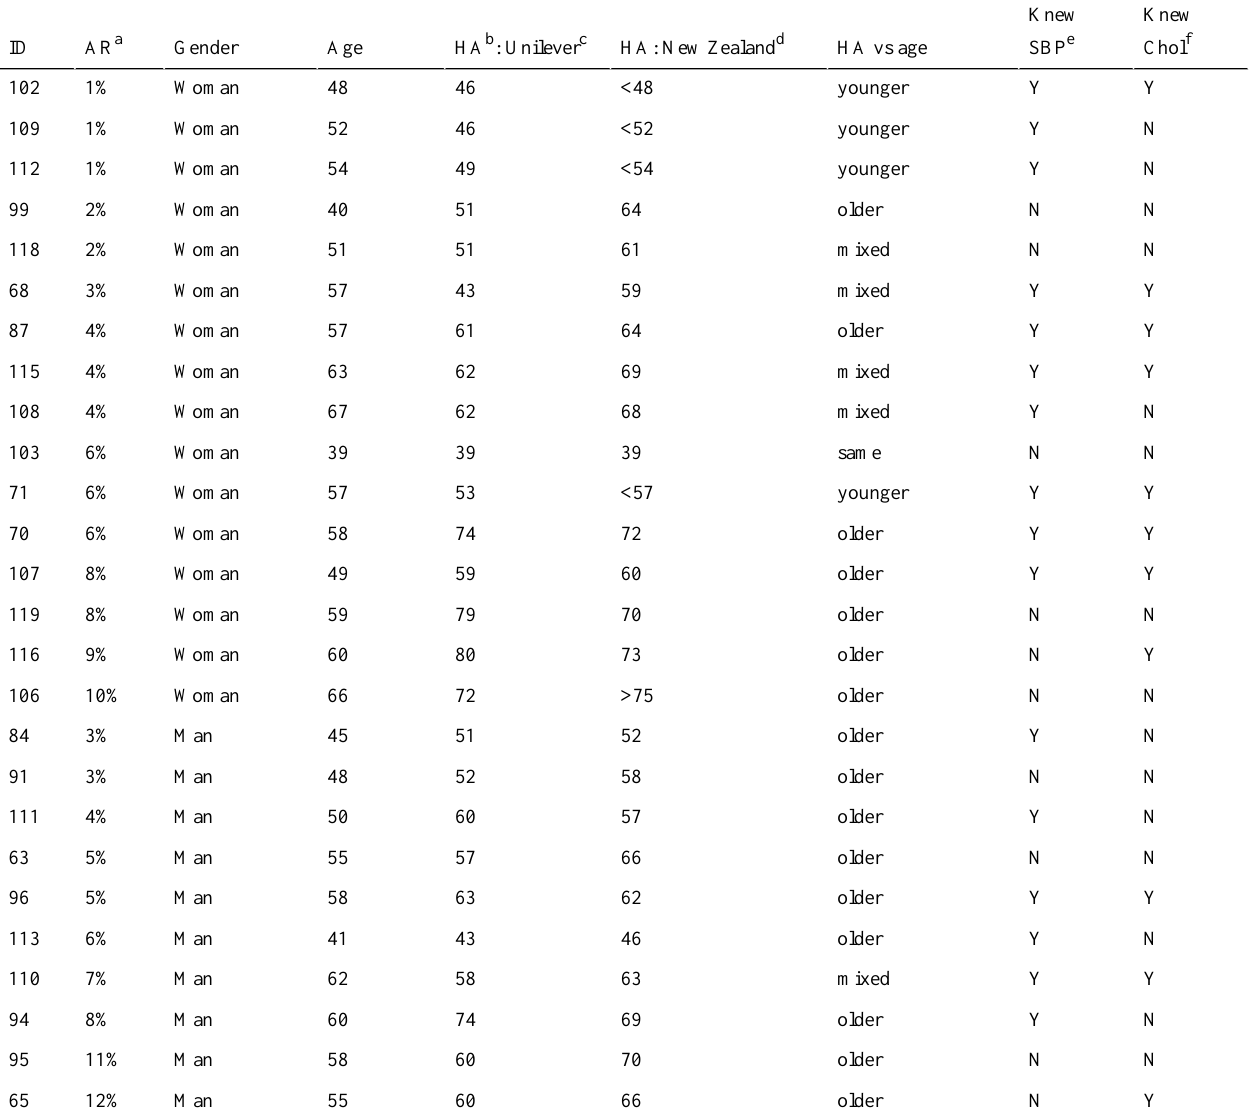
Table 1. Participant characteristics in order of absolute risk result, by